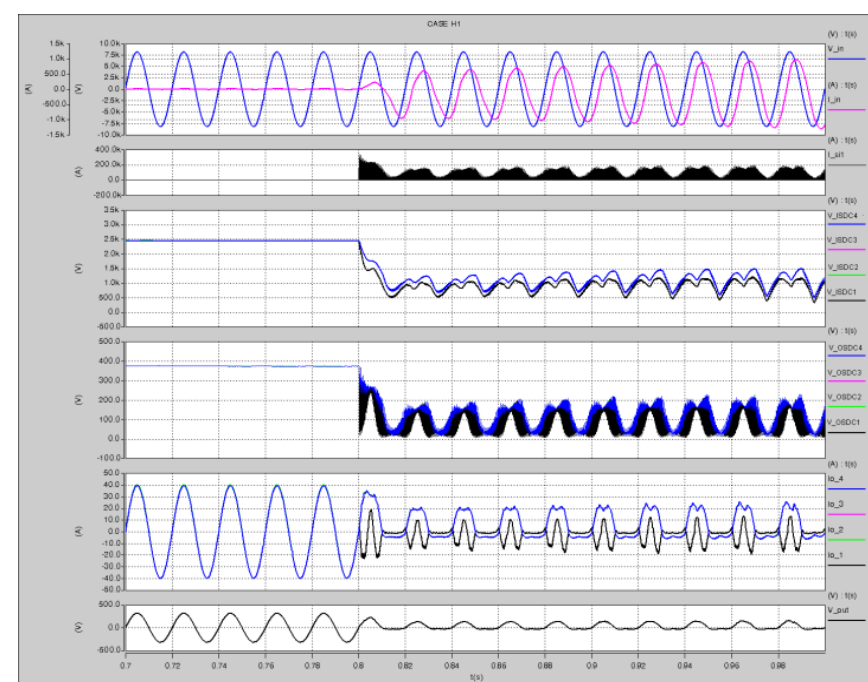
Figure 21. Simulation results of fault